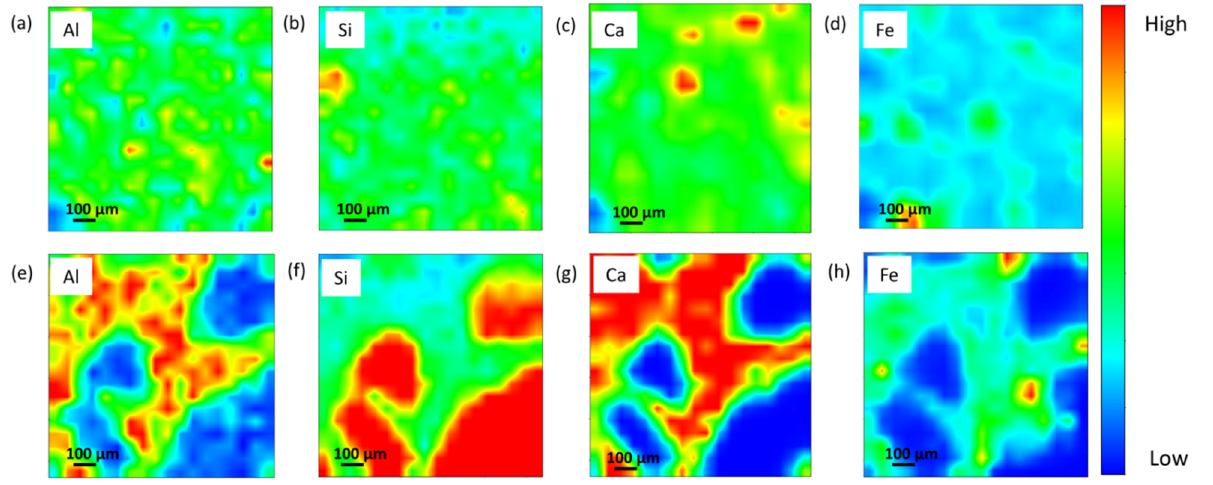
Figure 5. Micro-XRF elemental distribution maps of Al, Si, Ca and Fe of fly ash geopolymer mortar at 28 days ( a – d ) and 10 years ( e – h ) curing age.